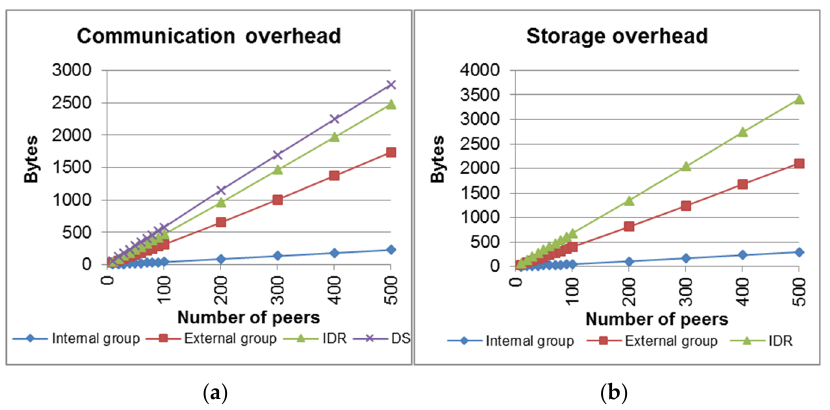
Figure 5. Communication ( a ) and storage ( b ) overheads in bytes for a system with delays from 50 to 250 milliseconds.